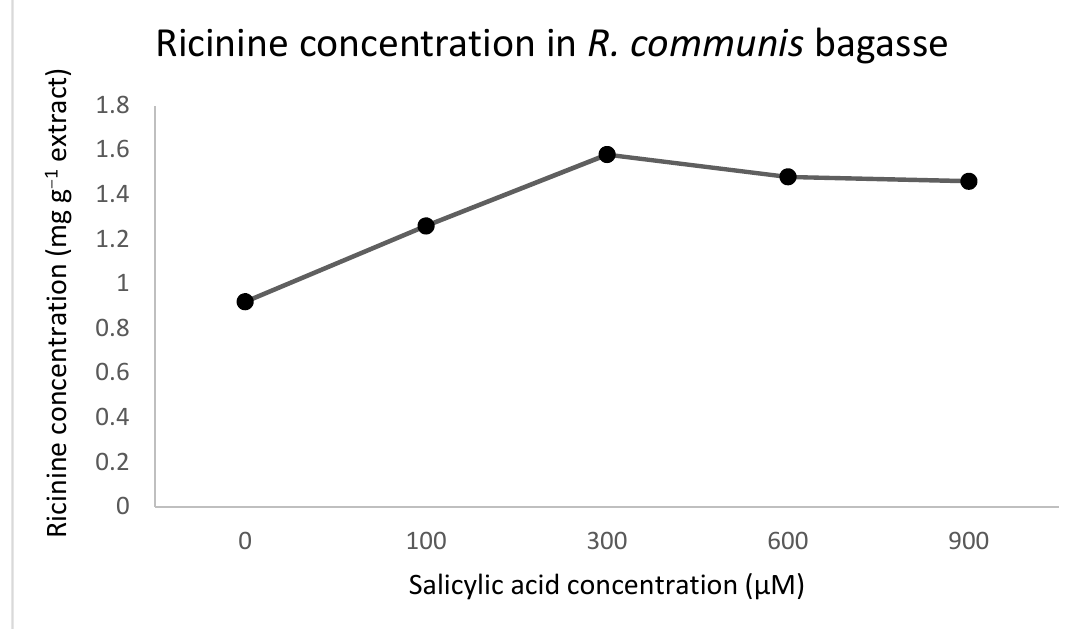
The data of concentration is the average of 3 measures ± standard deviation.